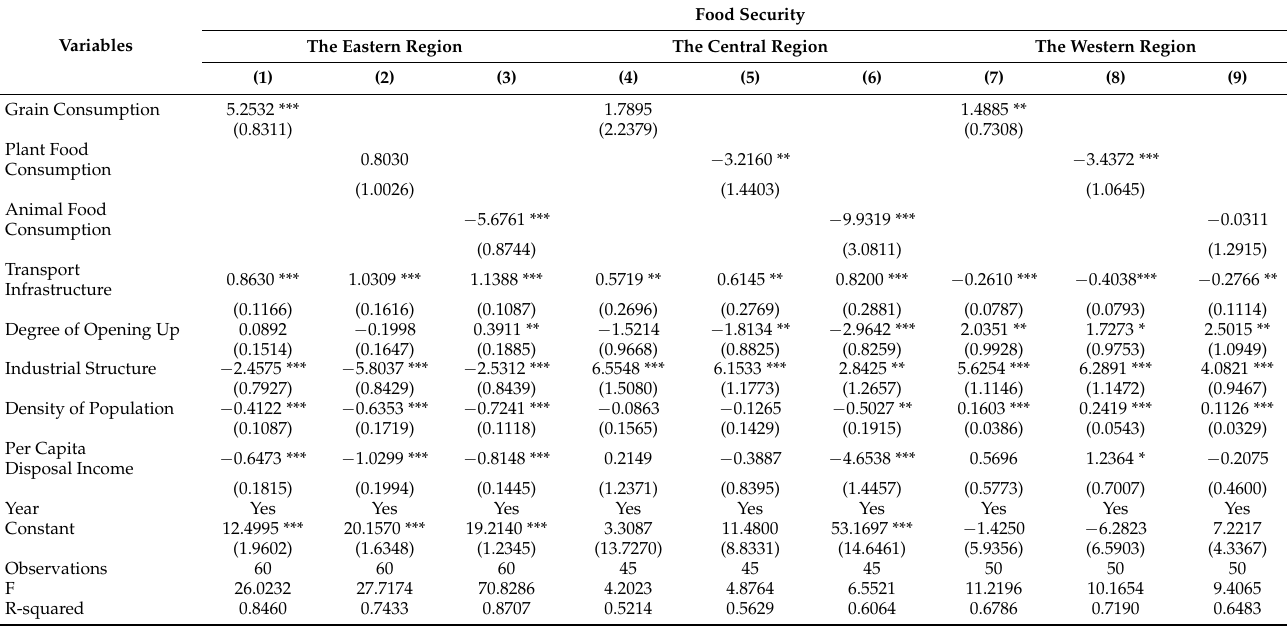
Table 10. Estimation of heterogeneity regression in different